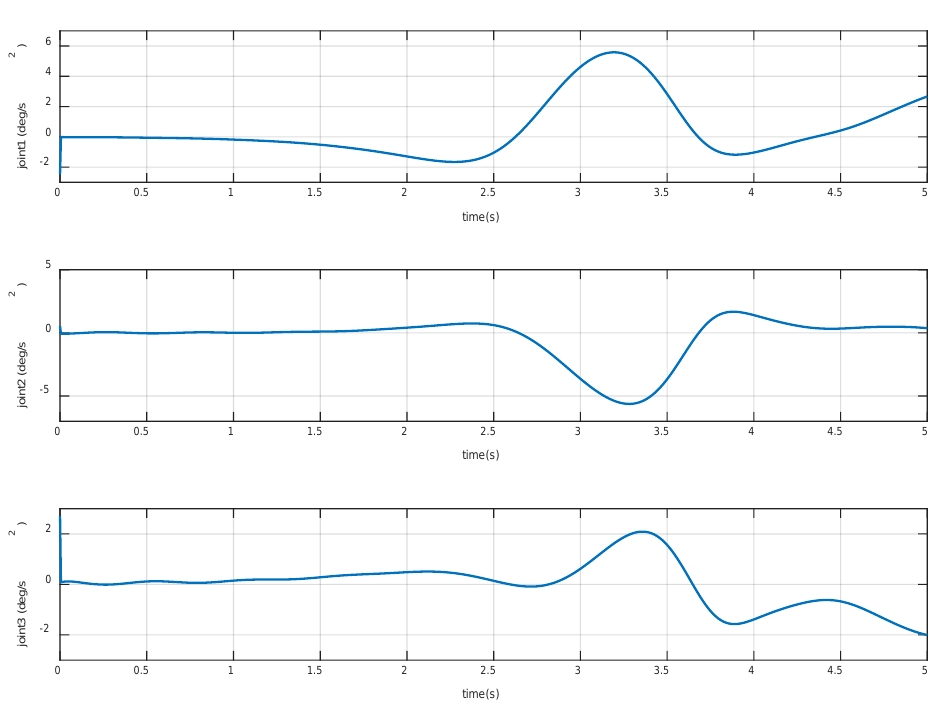
Figure 9. Errors of joint accelerations.